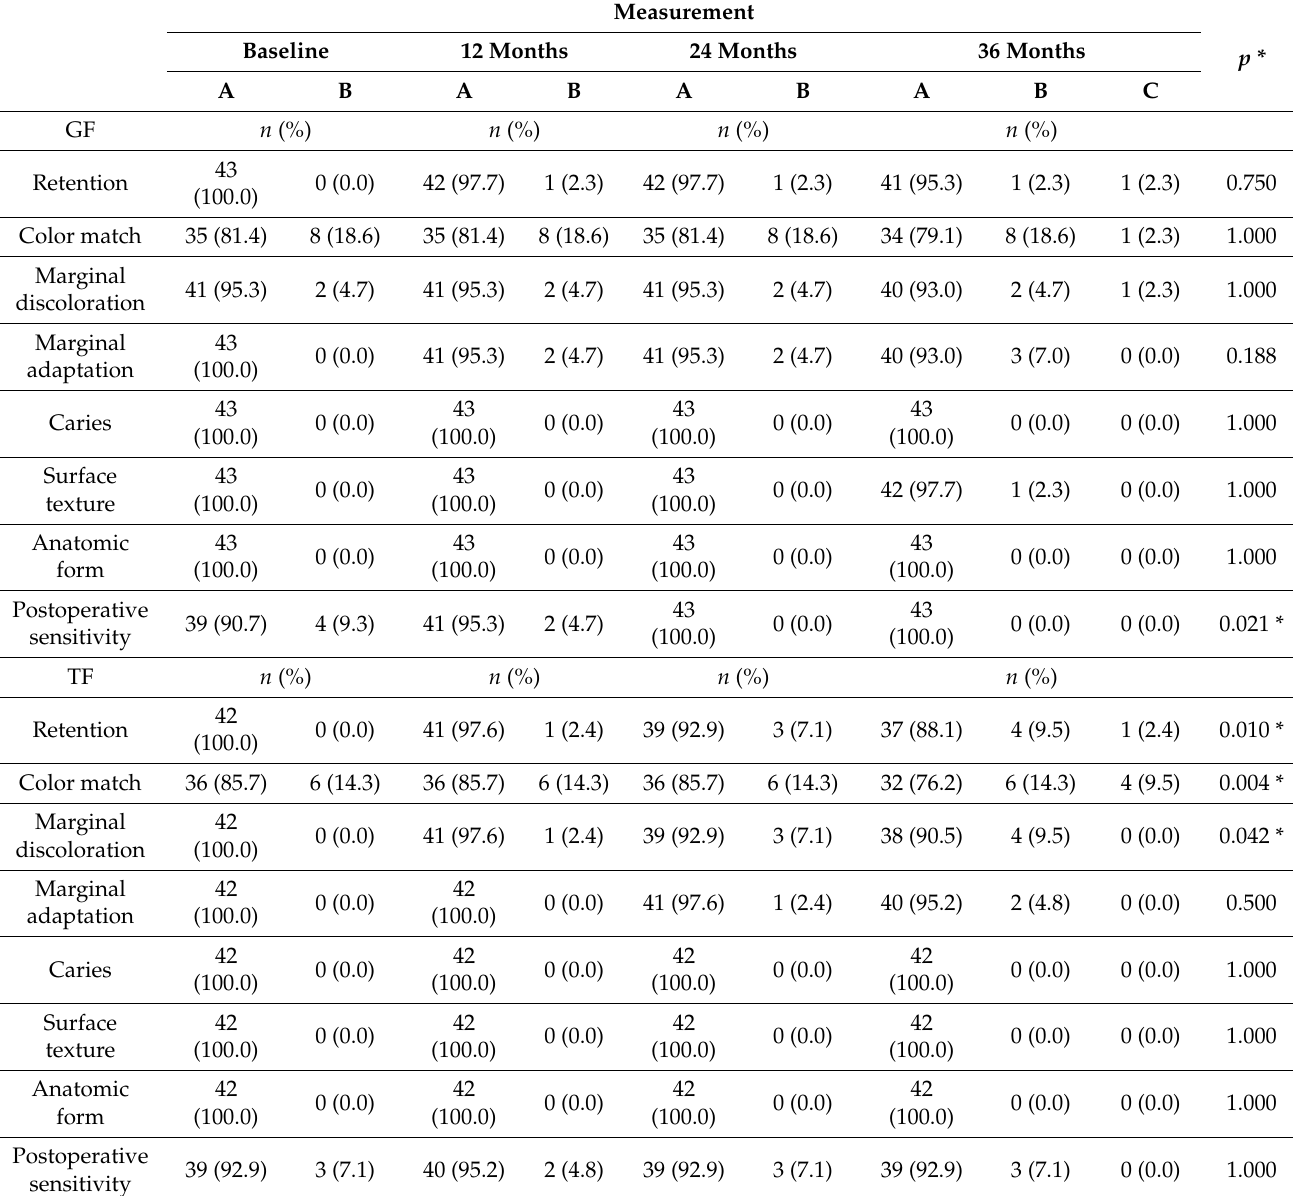
Table 4. Analysis of tested materials through the period of baseline, 12, 24, and 36 months considering USPHS criteria. A: Alpha score. B: Bravo score. C: Charlie score. D: Delta score. * Statistical